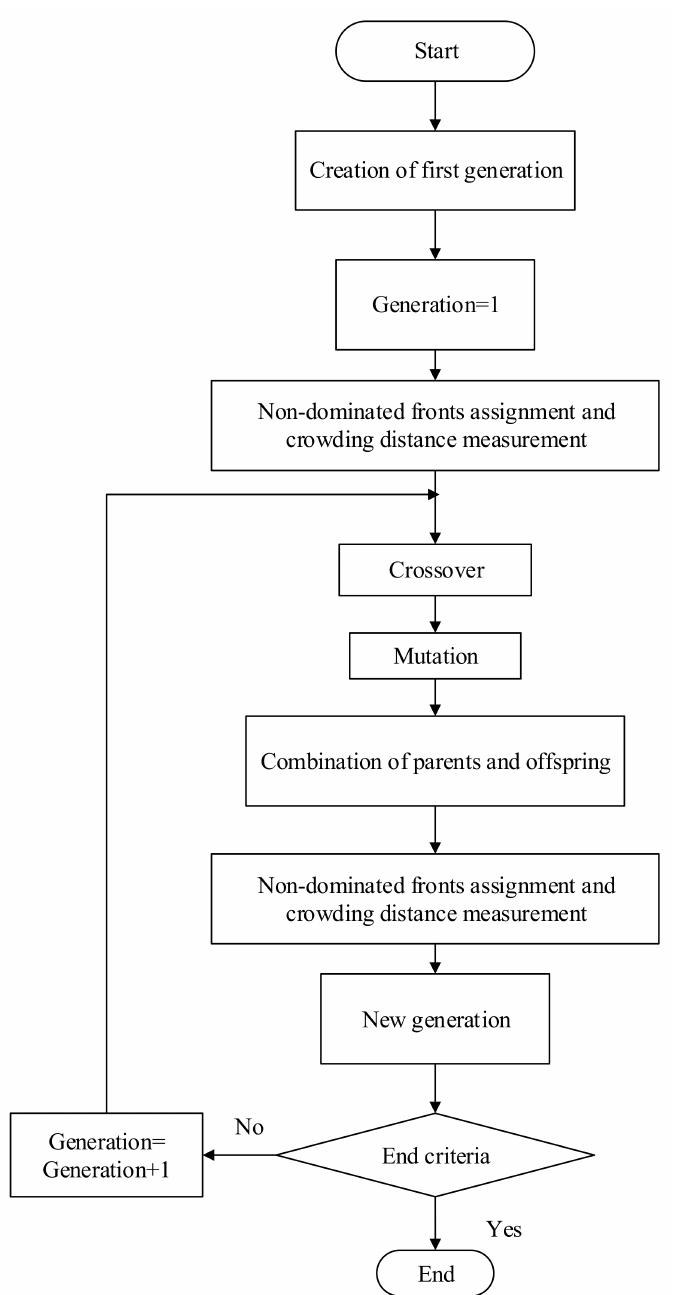
Figure 4. Flow chart of the non-dominated sorting-based genetic algorithm